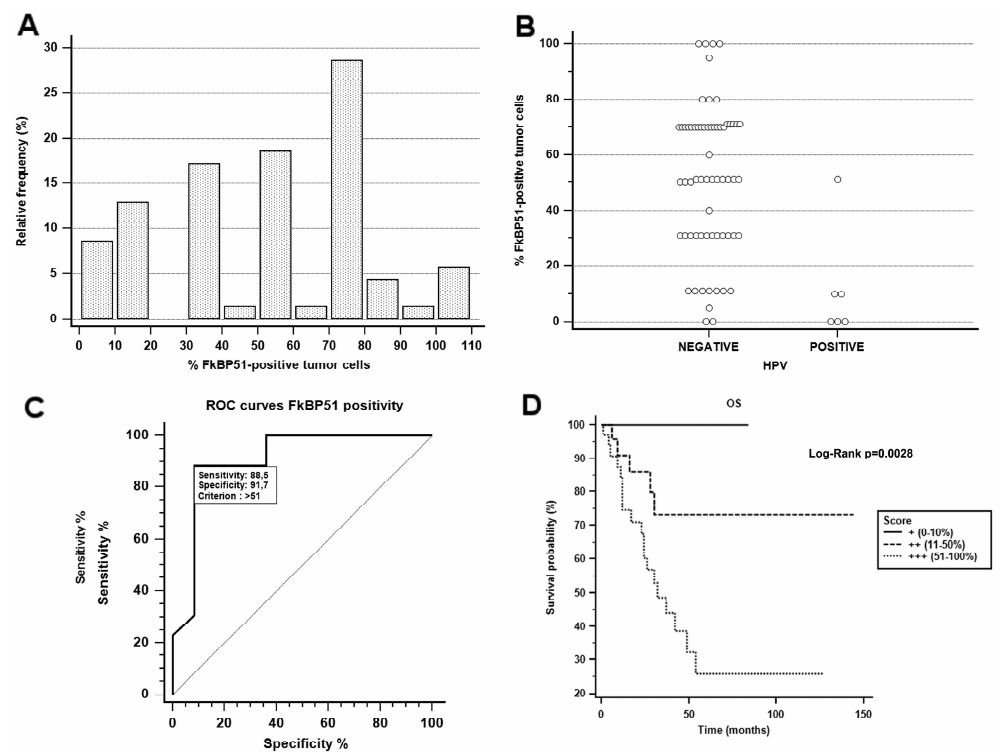
Figure 3. ( A ) Relative frequency of FKBP51 % of positive tumor cells in the case population studied; ( B ) p16 INK4a staining plotted against FKBP51 IHC results; ( C ) FKBP51 IHC expression ROC curves; ( D ) Kaplan–Meier curves. Patients were grouped into three risk categories according to FKBP51 expression (+: 0%–10%; ++: 11%–50%; +++: 51%–100%). Table 2. ROC curves analysis: the area under the ROC curves is 0.907 with a 95% CI ranging between 0.806 and 0.966 ( p -value < 0.0001). At the criterion value >51, the sensitivity and specificity of the test are 88.46 (95% CI 69.8–97.6) and 91.67 (95% CI 77.5–98.2), respectively.